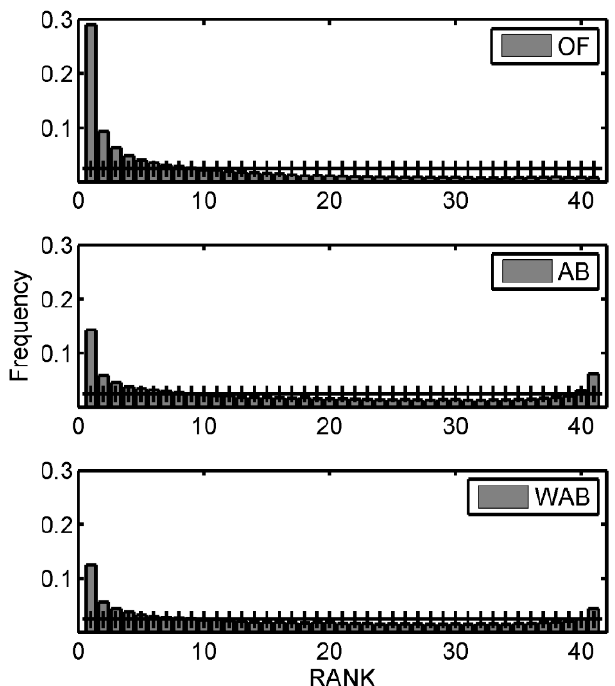
Figure 6. Rank histogram of ensemble forecasts, including original forecast (OF), and predictions from average bias correction (AB) and weather adapted bias correction (WAB). The black line with marks “+” is the ideal flat distribution.